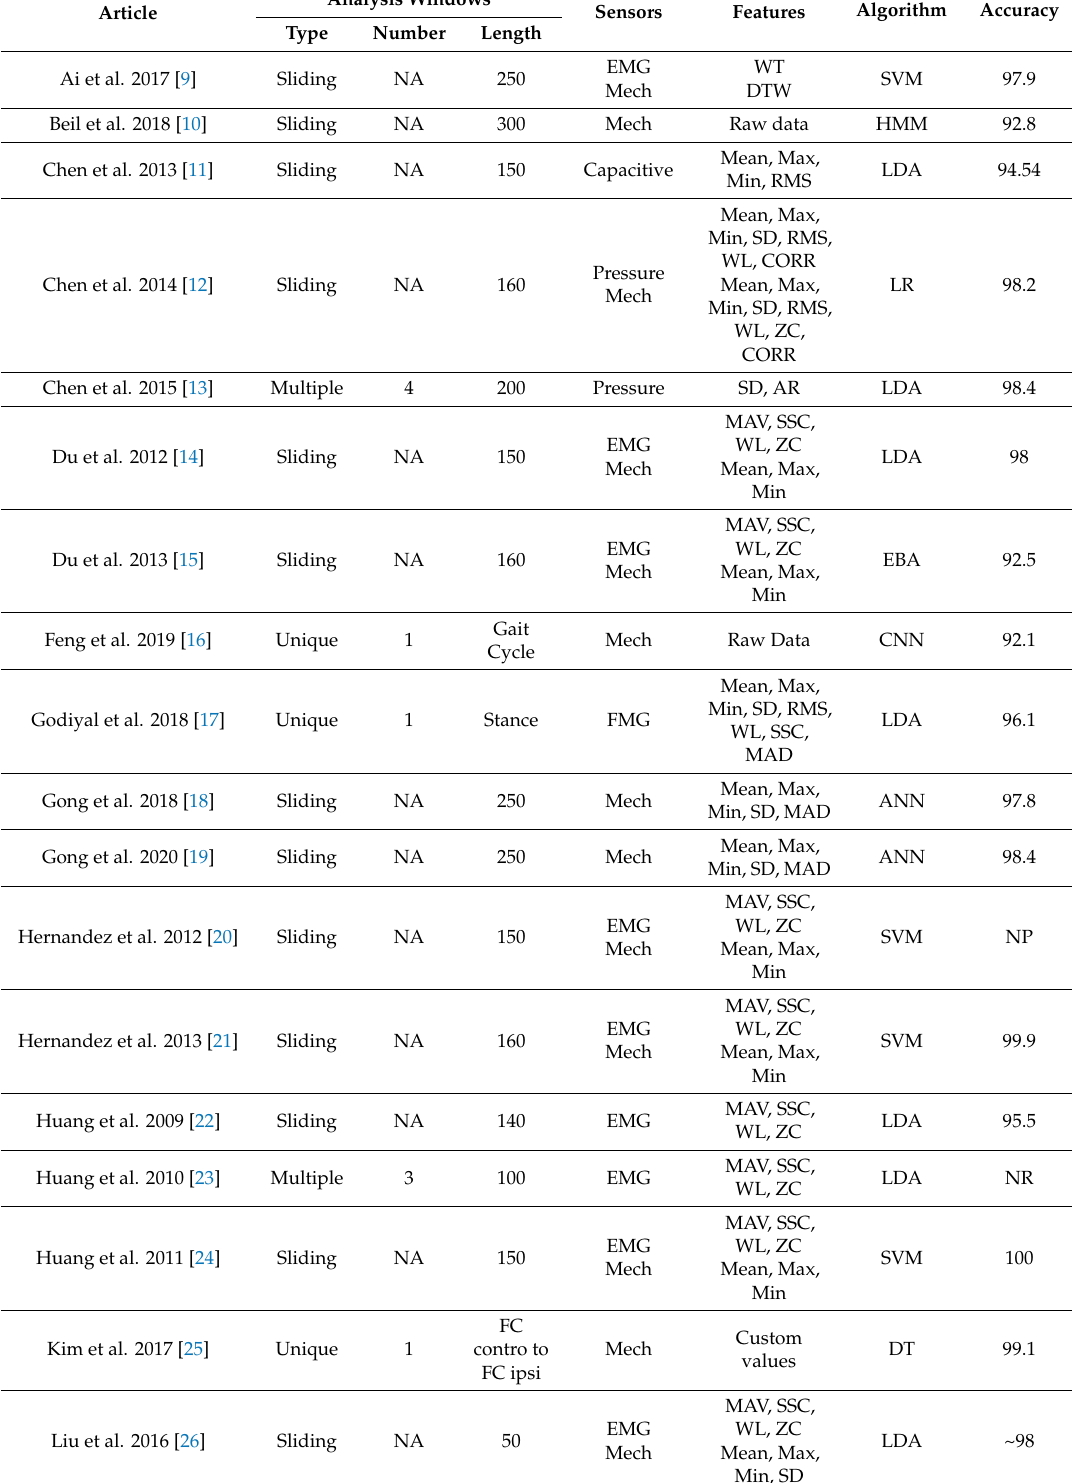
Table 3. Preprocessing techniques, Machine Learning algorithms and reported accuracies of the included studies. The details of the preprocessing techniques (windows and features) and the machine learning algorithms used in each study are reported along with the corresponding accuracy. If several configurations were tested, only the optimal configuration is